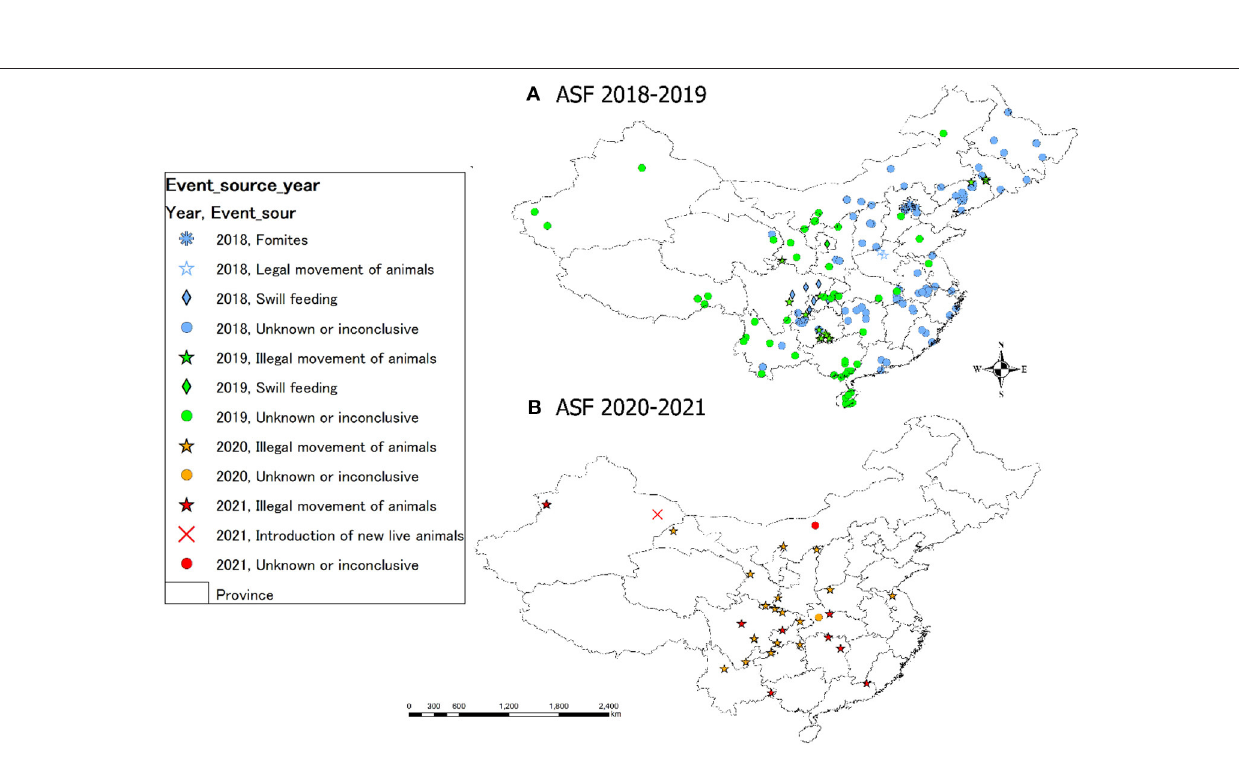
Frontiers in Veterinary Science |